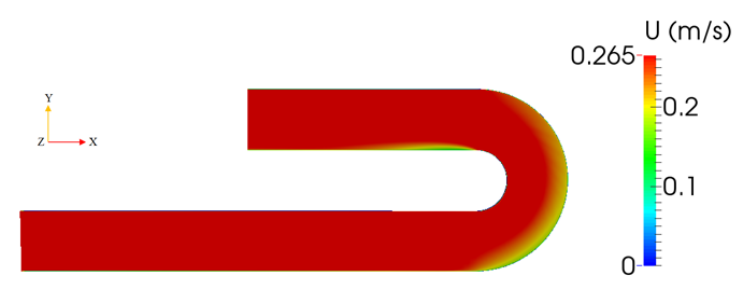
Figure 6. The distribution of water surface velocity (Standard k- ε ).